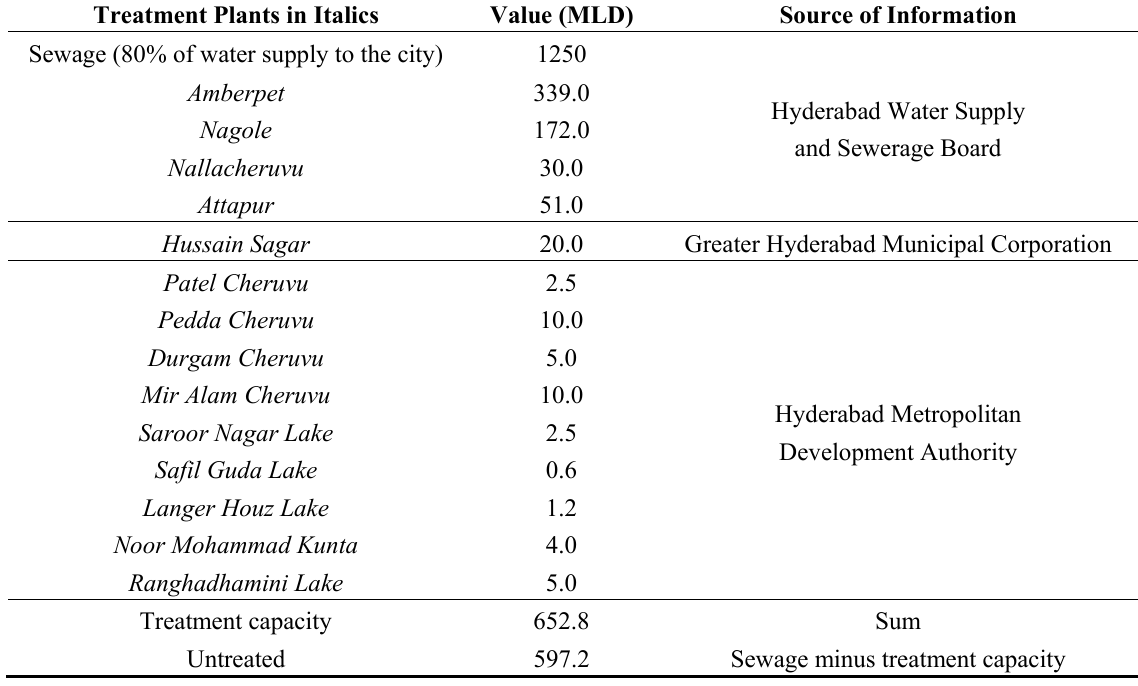
Table 1. Current wastewater treatment capacity of sewage treatment plants and systems associated with lakes.